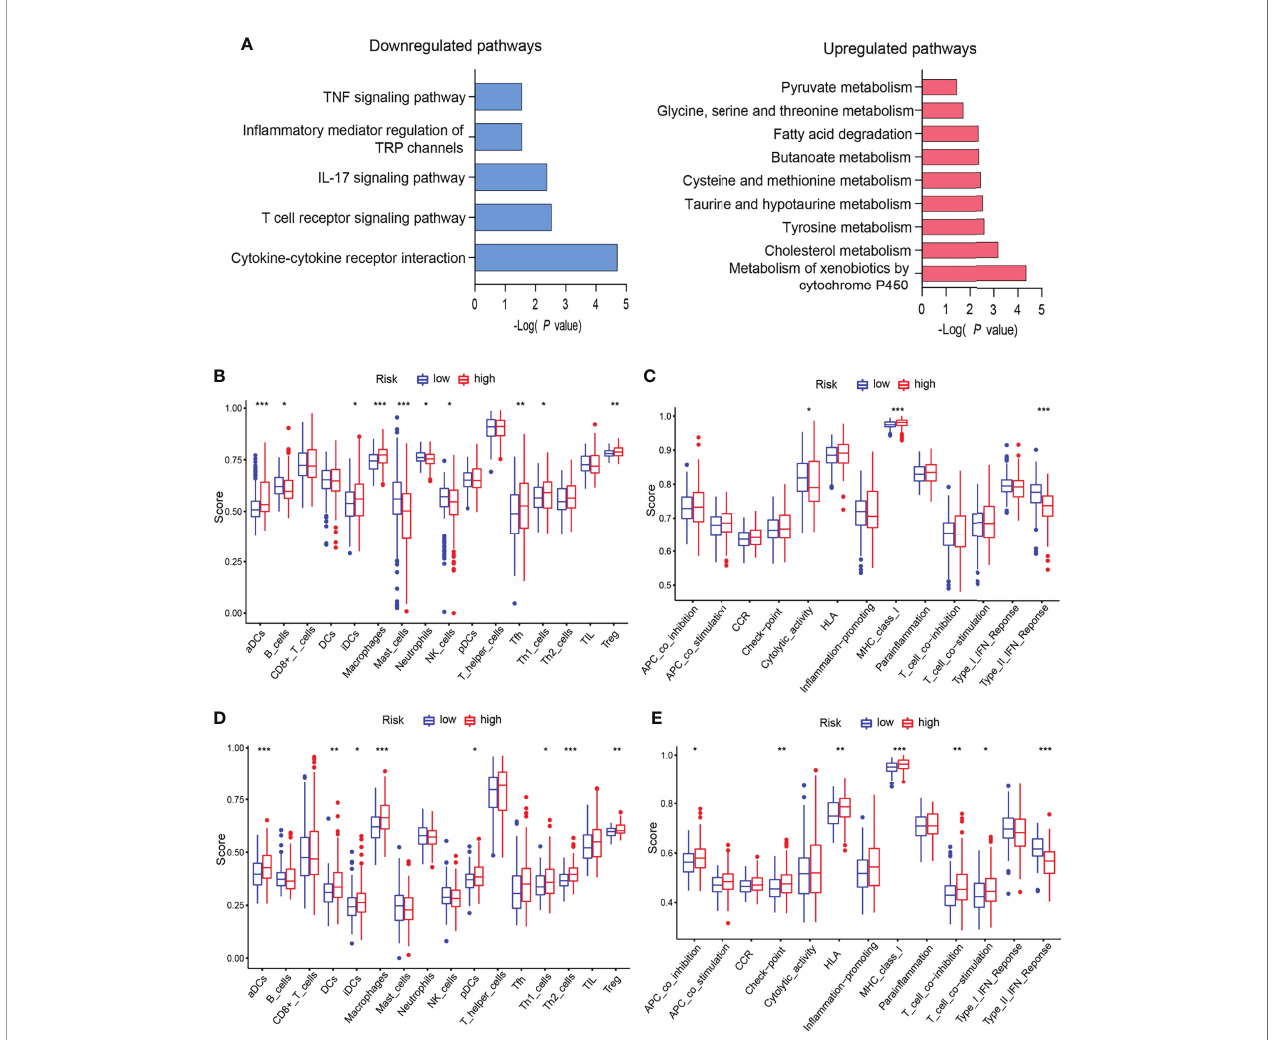
FIGURE 4 | EGRscore correlated with immune microenvironment. (A) KEGG of DMGs in the high- and low-risk groups in the TCGA-LIHC cohort. (B) Comparison of immune cell in fi ltration in the high- and low-risk groups in the TCGA-LIHC cohort. (C) Comparison of immune function in the high- and low-risk groups in the TCGA-LIHC cohort. (D) Comparison of immune cell in fi ltration in the high- and low-risk groups in the ICGC-JIHC cohort. (E) Comparison of immune function in the high- and low-risk groups in the ICGC-JIHC cohort. Statistical signi fi cance was denoted with *(p < 0.05), **(p < 0.01), and ***(p <